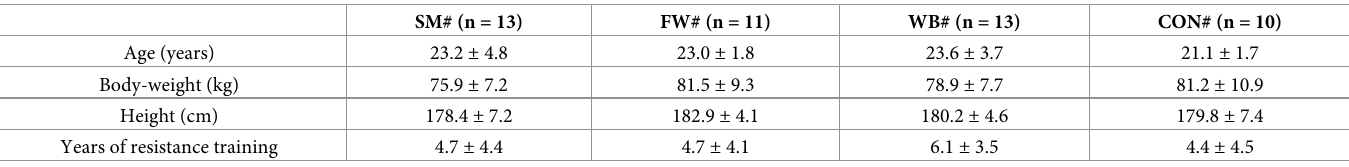
Table 1. An overview of the anthropometric data and years with resistance